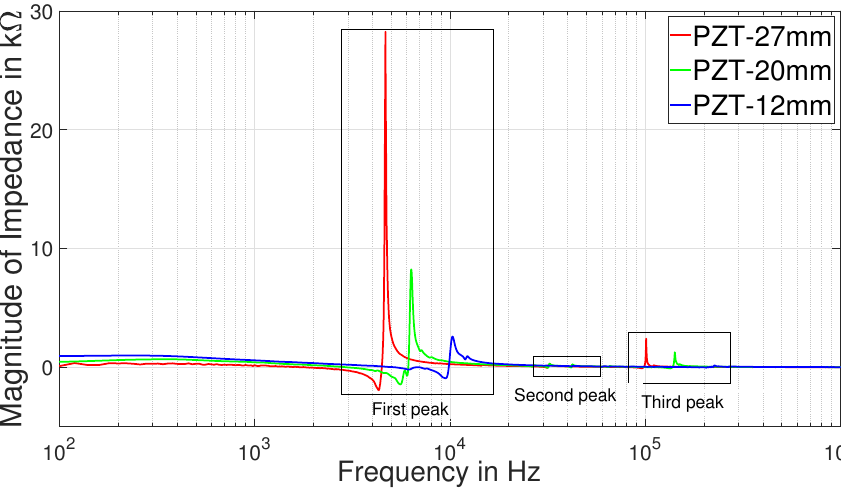
Figure 12. Magnitude of residual impedance of three